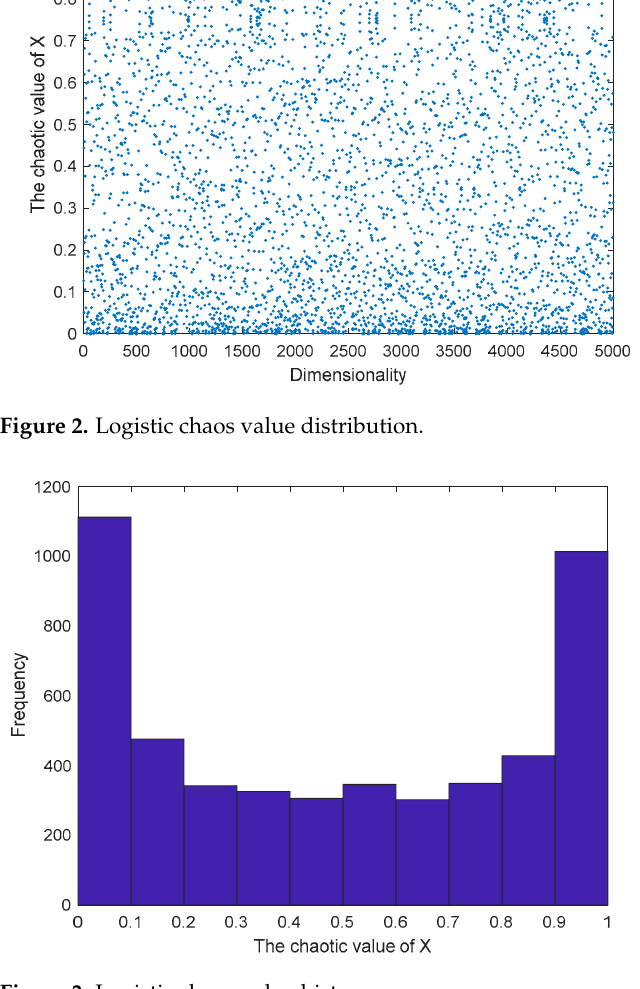
Figure 3. Logistic chaos value histogram. Therefore, an improved logistic chaotic mapping is proposed, as shown in Figures 4 and 5. The improved logistic chaotic mapping values are more uniformly distributed, the per- centage of each region in the interval [0, 1] does not differ much from each other, and the initialized particles are more evenly distributed. The chaotic sequence generated by the improved logistic chaos mapping is introduced into the search space of whale individuals to generate the sequence of individual positions in the initial stage of the whale optimization algorithm to improve the initial population distribution of whales, whose mathematical model expression